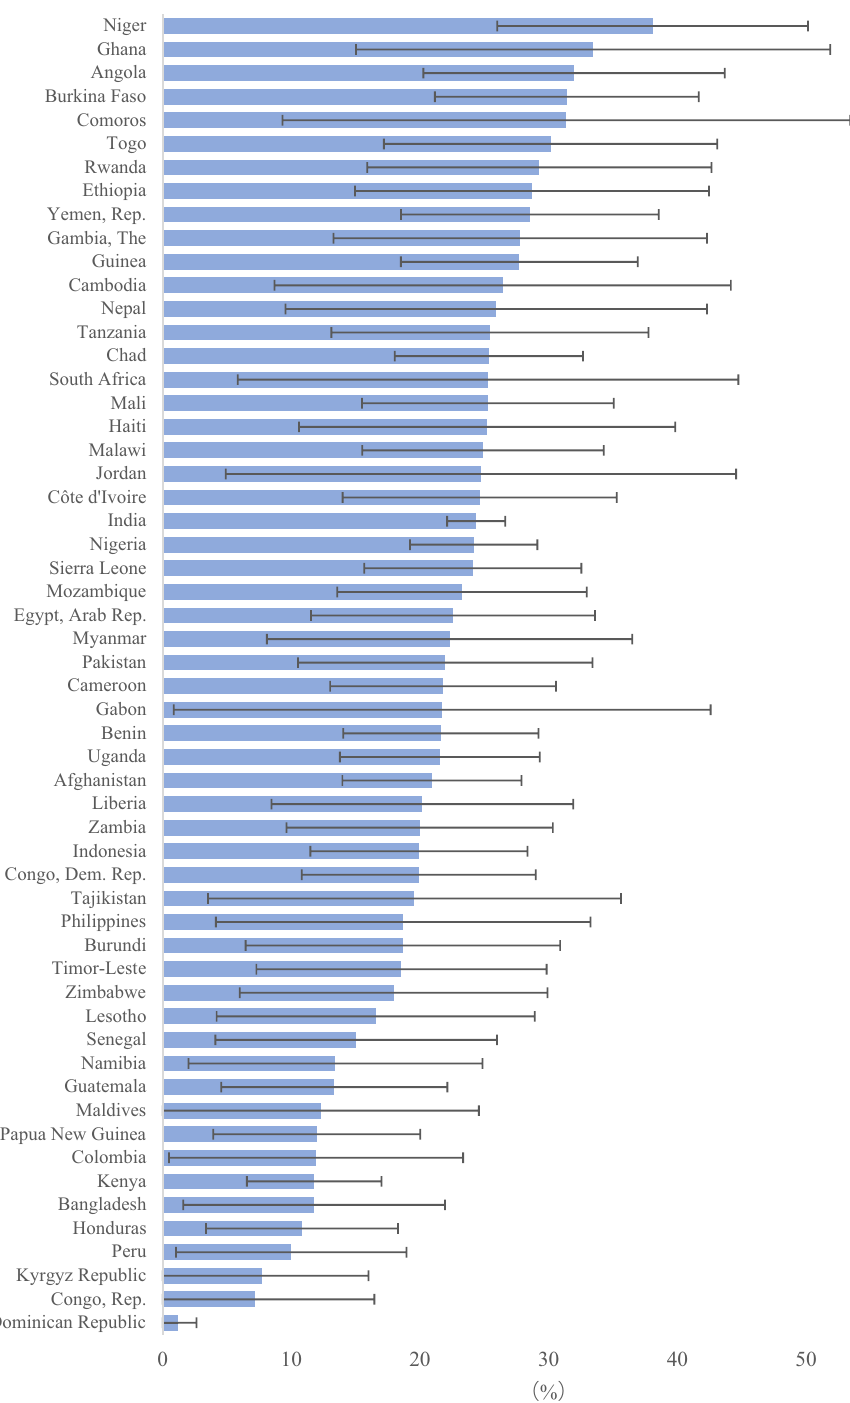
Figure 2. The percentage of neonatal deaths occurring to mothers with history of neonatal